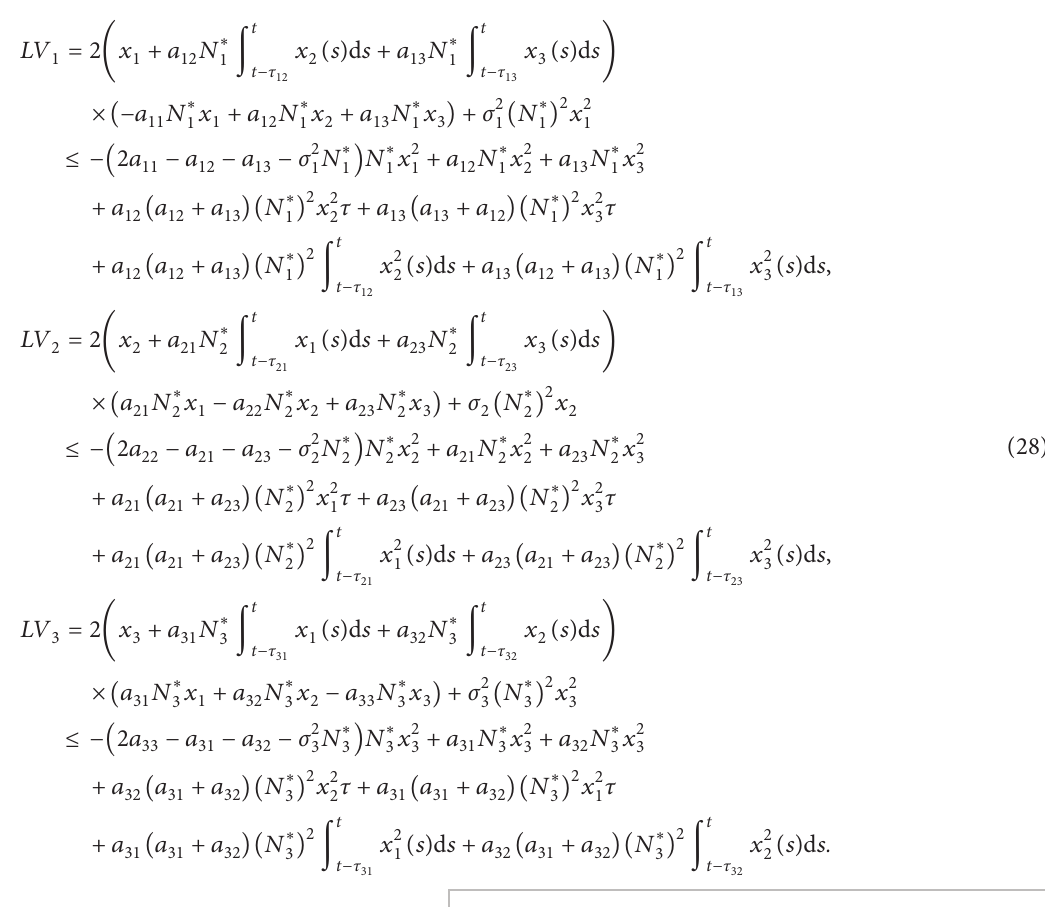
Figure 1: Unstable cases with large time delay, where σ destroys the stability of (4) and (6), respectively. (a) The state graph of system (4); (b) the state graph of system